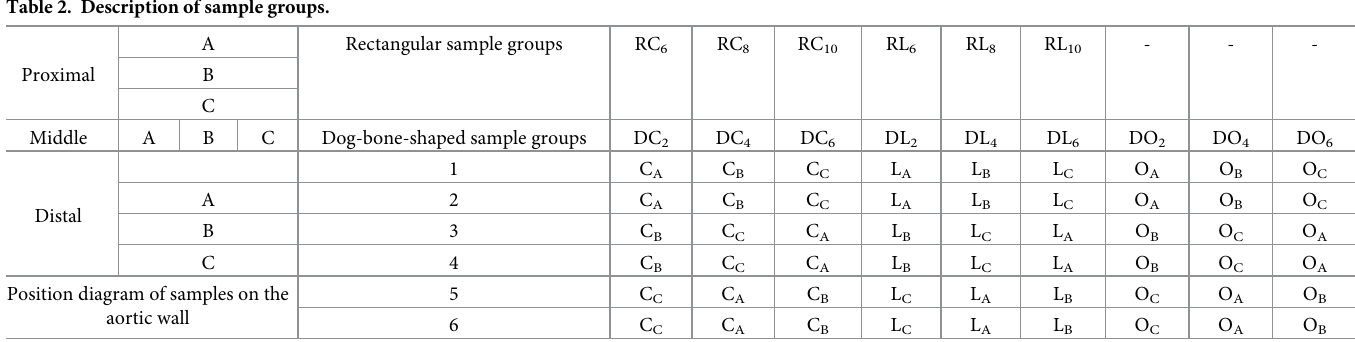
Table 2. Description of sample